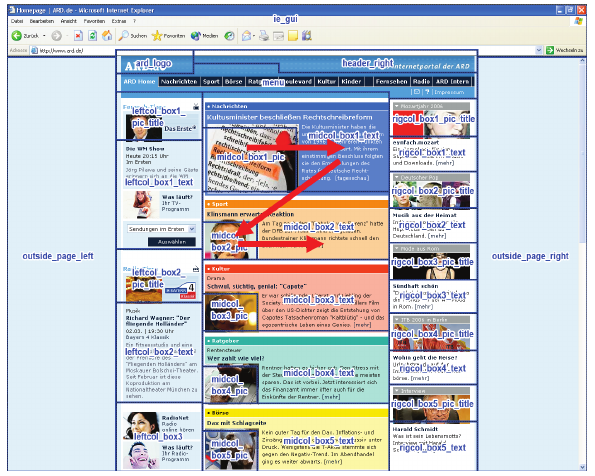
Figure 10. Often-repeated ARD pattern involving 4 ROIs, occurring in 8 out of 10 presentations, initially in presentation 1 (participant 12)